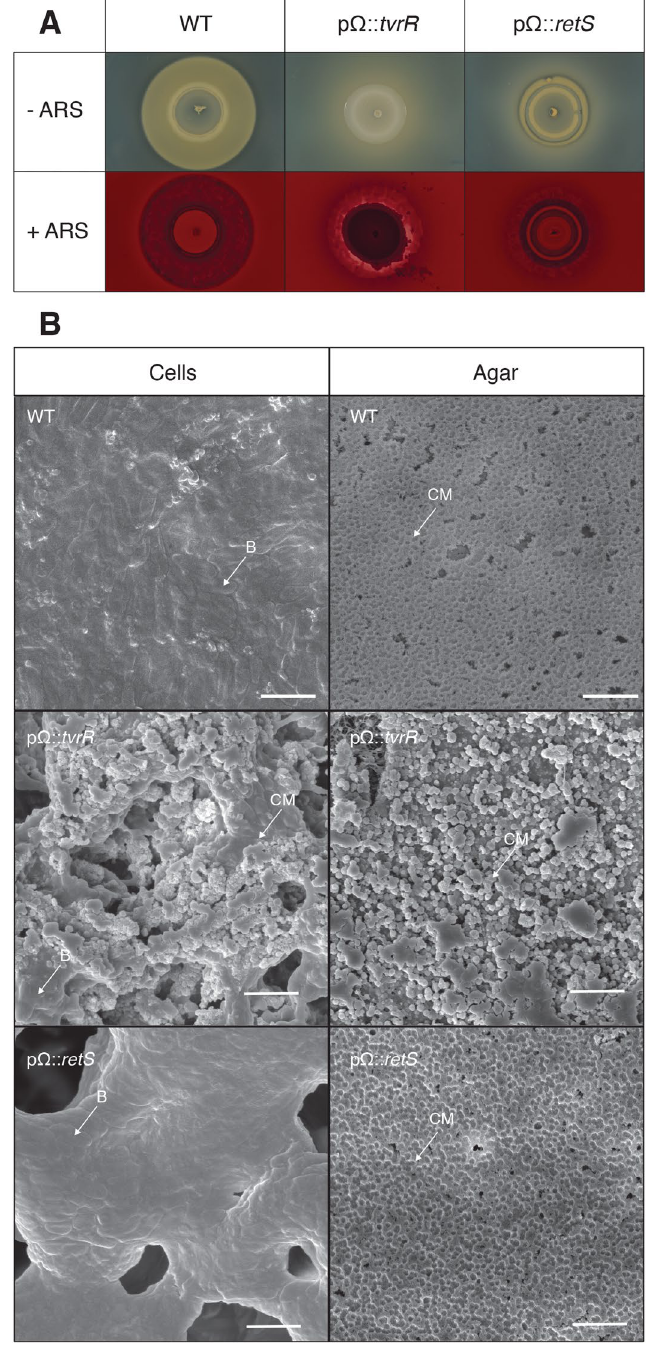
Figure 7. ( A ) Pictures of P. syringae pv. tomato DC3000, P. syringae pv. tomato DC3000 pΩ:: tvrR , and P. syringae pv. tomato DC3000 pΩ:: retS grown on NB agar supplemented with calcium after four days of growth on plates. Pictures were taken of the same colony before and after staining of the colonies with 1.0% (w/v) ARS. These pictures are representative of the phenotype observed in each strain after four days of growth on NB agar supplemented with calcium. This assay was repeated with three independent biological replicates and these pictures are representative of what was observed each time. ( B ) SEM images at 18,000x magnification of colony surface for P. syringae pv. tomato DC3000, agar adjacent to P. syringae pv. tomato DC3000, colony surface for P. syringae pv. tomato DC3000 pΩ:: tvrR , agar adjacent to P. syringae pv. tomato DC3000 pΩ:: tvrR , colony surface for P. syringae pv. tomato DC3000 pΩ:: retS , and agar adjacent to P. syringae pv. tomato DC3000 pΩ:: retS after six days of growth on NB supplemented with Ca 2 + . 2 µ m scale bars are indicated in the lower right-hand corner of the images. An arrow pointing to calcium phosphate (CM) and an arrow pointing at bacteria ( B ) are included in the images when calcium phosphate or bacteria were present. Bacterial cells and agar were imaged with three independent biological replicates. The images used are representative of what was observed each